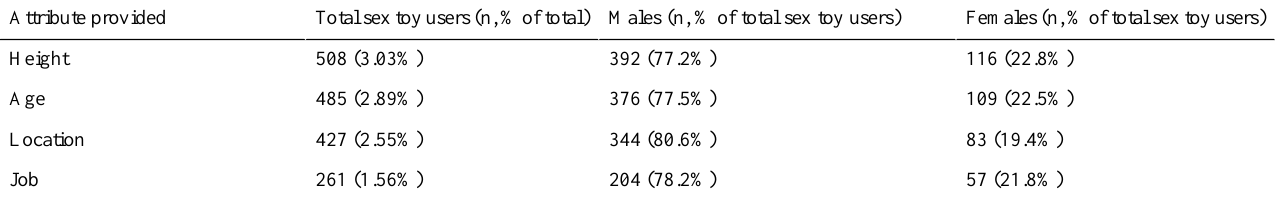
Table 2. Sex toy–owning users according to attribute information provided.